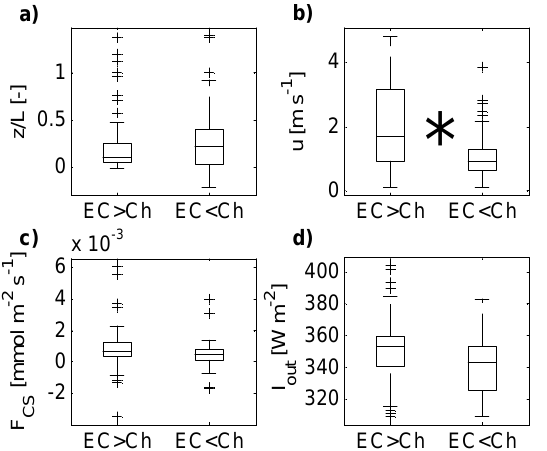
Fig. 4. Comparison of (a) nighttime atmospheric stability ( z/L ), (b) wind velocity ( u ), (c) CO 2 flux by coherent structures ( F CS ) and Figure 4. Comparison of a) nighttime atmospheric stability (z/L), b) wind velocity (u), c) CO 2 361 (d) long-wave outgoing radiation ( I out ) while either EC or chamber flux by coherent structures (F CS ) and d) long wave outgoing radiation (I out ) while either EC or 362 CO 2 fluxes are larger, highly significant difference (Student’s t test for dependent samples, ∗ = p <0.01) found only in case of u (as well chamber CO 2 fluxes are larger, highly significant difference (Student’s t–test for dependent 363 as u ∗ ) . samples, * = p<0.01) found only in case of u (as well as u * ). 364